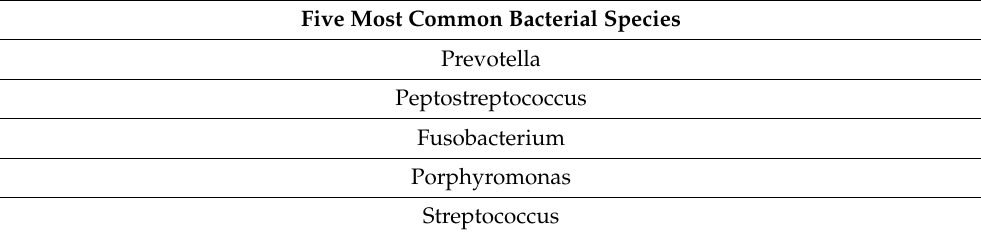
Table 2. The five most common bacterial species found in severe odontogenic infections based on our institution’s experience and the available literature